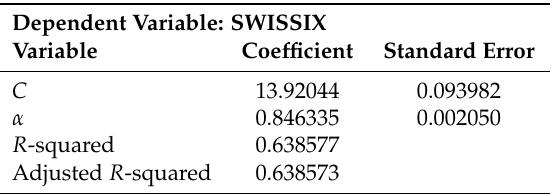
Table 4. Linear regression between Swissix and Phelix price series.